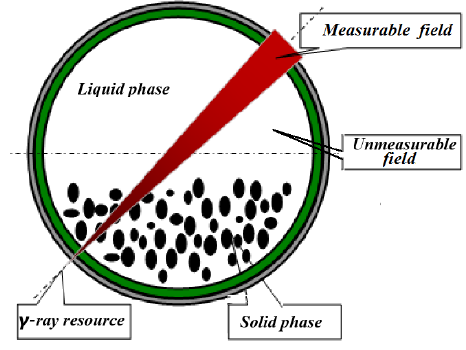
Figure 1. Principle of the γ -ray sensor.